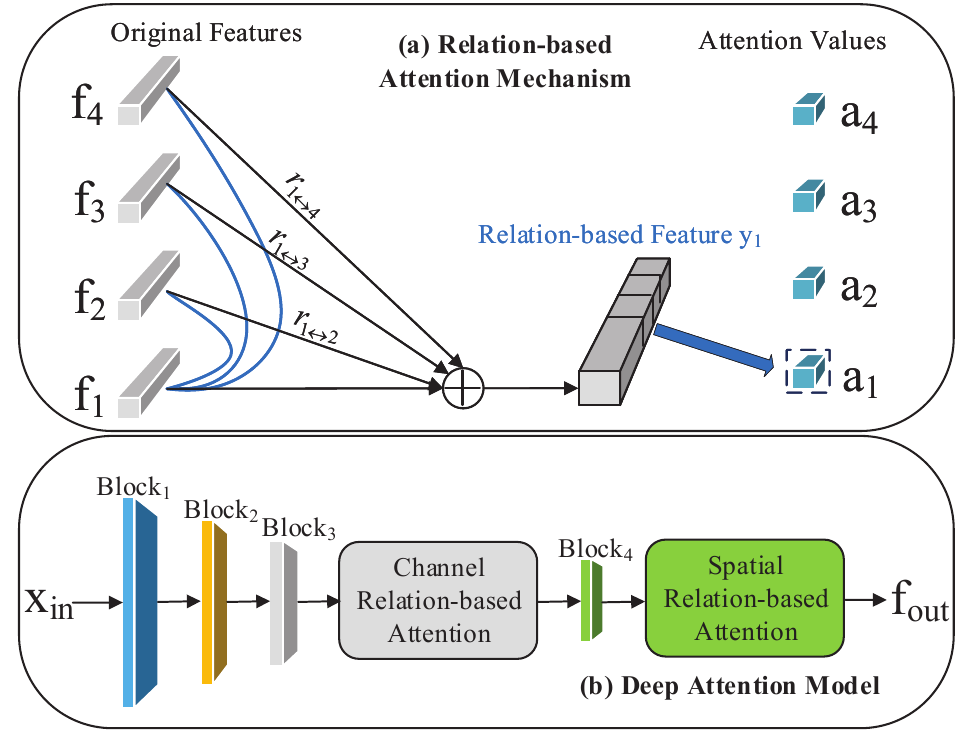
Figure 3. Illustration of our relation-based attention module: ( a ) an example of building the relation information with feature f 1 . The feature of each sample is associated with all other samples before obtaining its group-wise attention value; ( b ) details of our deep attention module. We add our designed channel relation-based attention module and spatial relation-based attention module to block3 and block4 of ResNet50